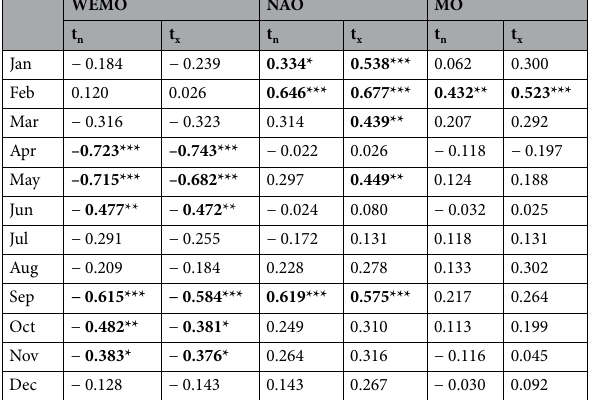
Table 2. Nonparametric Spearman correlation r between monthly values of t x and t n and three teleconnection indices over 1980–2015: WEMO, NAO and MO. Significant values are in bold with their significant